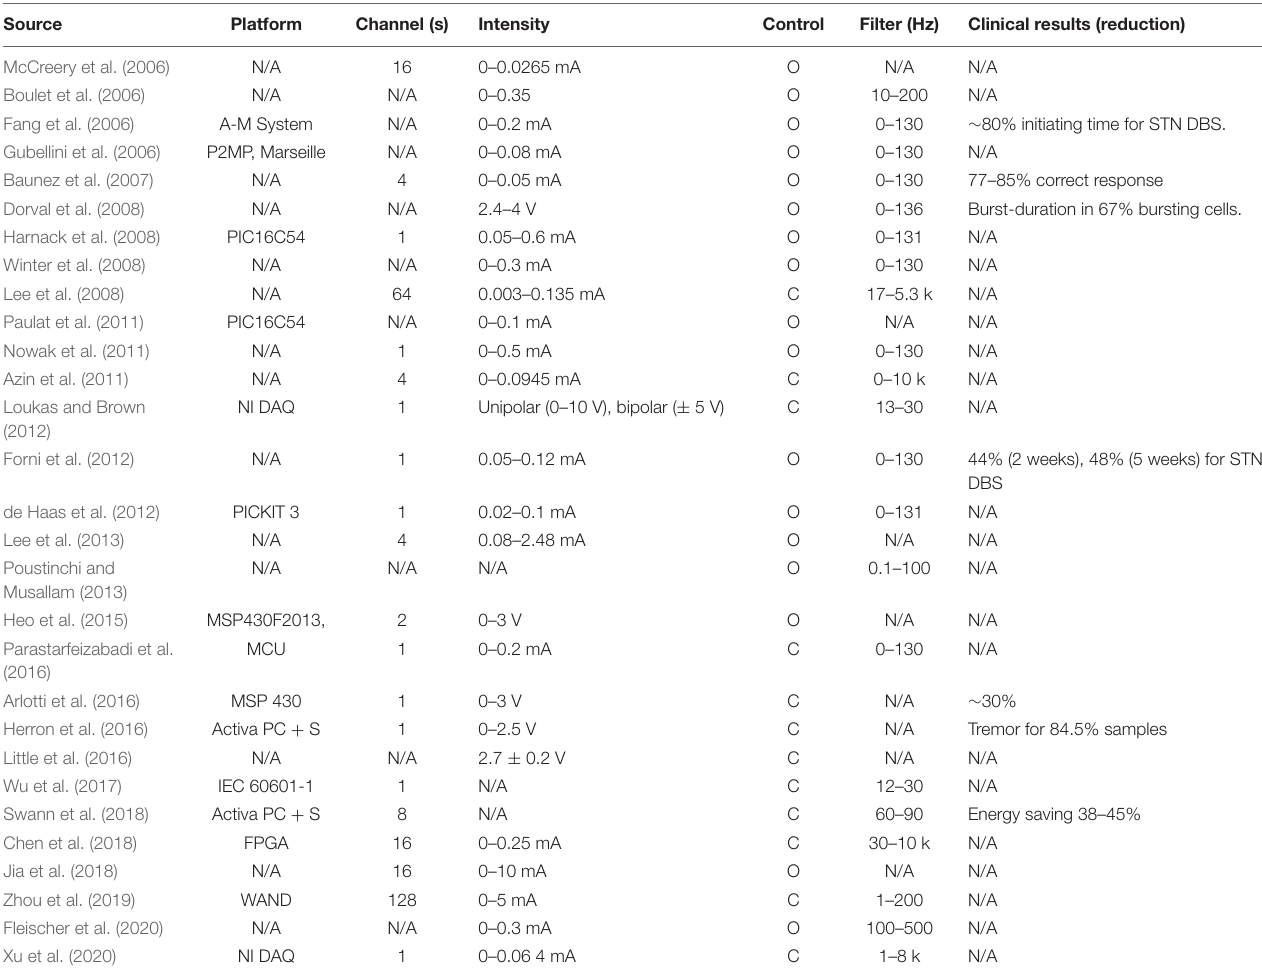
TABLE 3 | Recording and stimulation system for